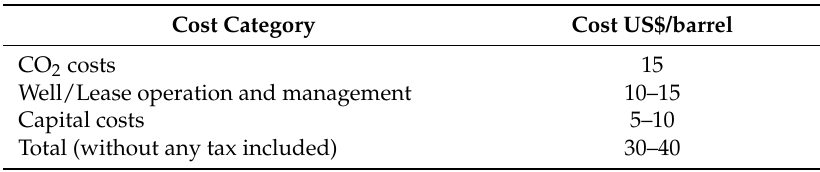
Figure 3. CO 2 ‐ EOR projects and oil prices in the US during 1980–2008 period [37]. Figure 3. CO 2 -EOR projects and oil prices in the US during 1980–2008 period [37]. Table 1. Costs involved in CO 2 -EOR